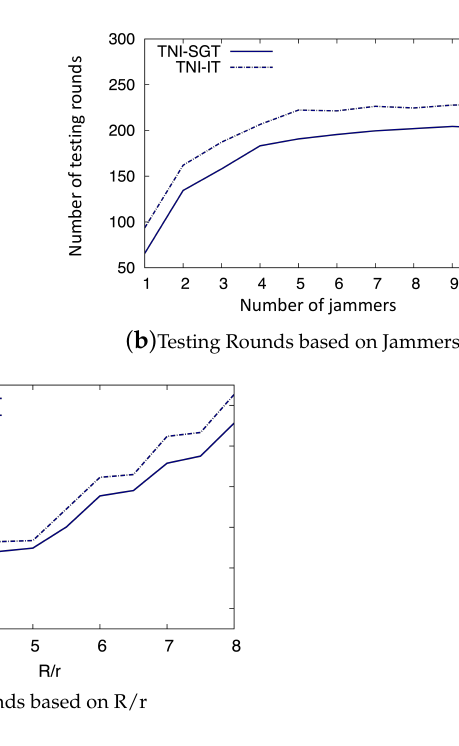
Figure 5. Rounds by Various